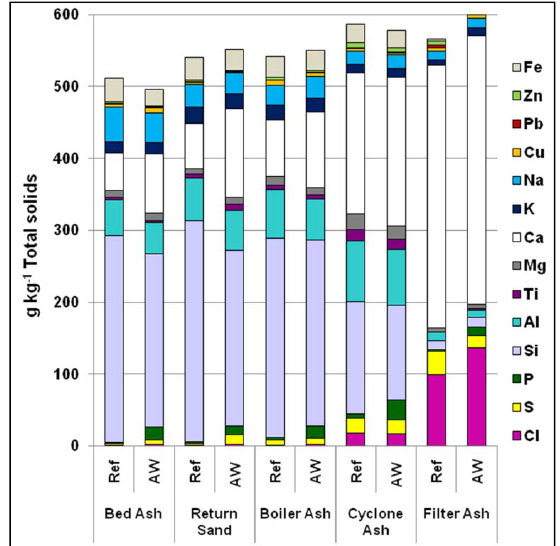
Figure 10. Elemental analysis of bed ash, return sand, boiler ash, cyclone ash, and filter ash, for the Ref and AW